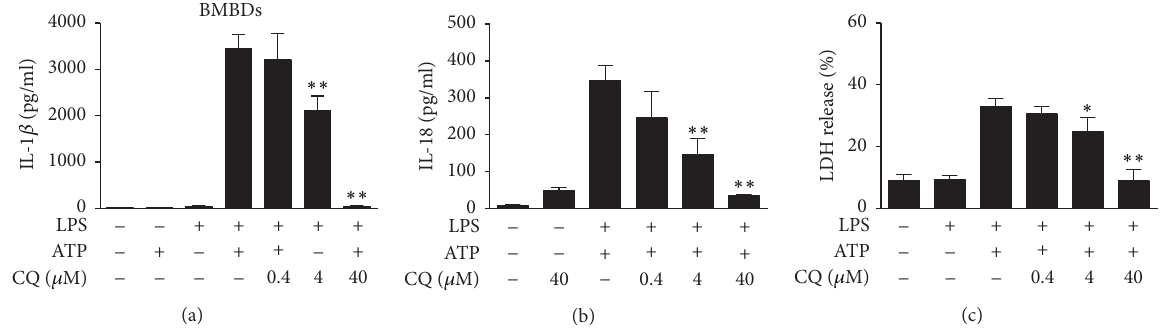
Figure 1: CQ suppress IL-1 𝛽 and IL-18 secretion in LPS- and ATP-primed BMDMs. BMDMs were pretreated with or without 0.4, 4, and 40 𝜇 M CQ for 1h and then stimulated with LPS (100 ng/ml) for 4h and ATP (2 mM) for an additional 1h. The IL-1 𝛽 and IL-18 levels in culture supernatants were determined by ELISA ( 𝑛 = 3 ). ∗∗ 𝑃 < 0.01 versus LPS plus ATP group (a-b). LDH release from BMDMs was measured by LDH assay (c). ∗ 𝑃 < 0.05 , ∗∗ 𝑃 < 0.01 versus LPS plus ATP group. All data were expressed as mean ± SEM in triplicate and are representative of three independent